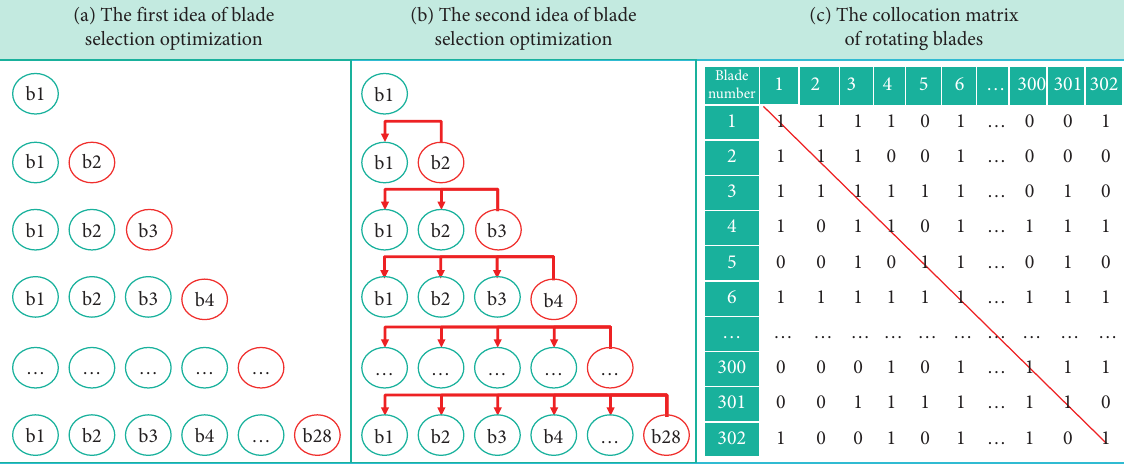
Figure 2: Two ideas of establishing blade optimization-selection algorithm and the collocation matrix of blades.